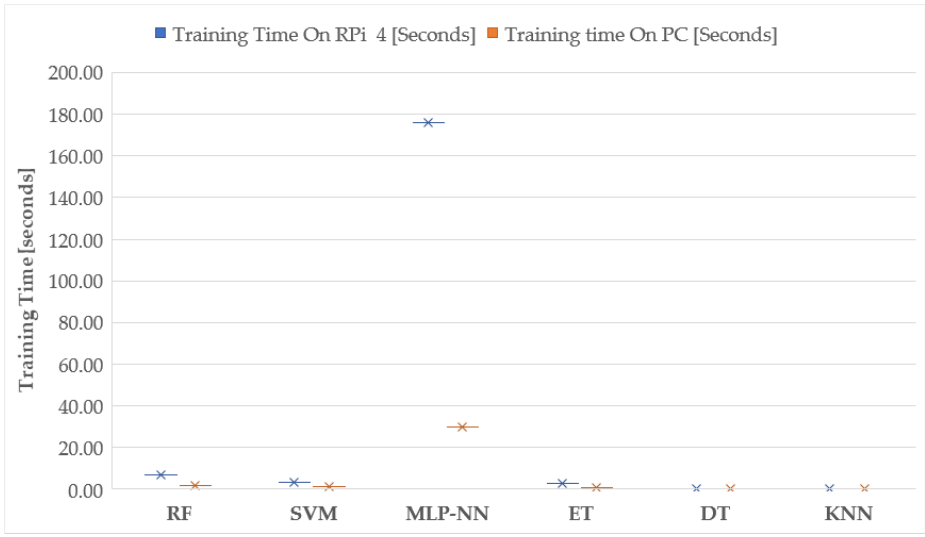
Figure 5. ML algorithms training time.